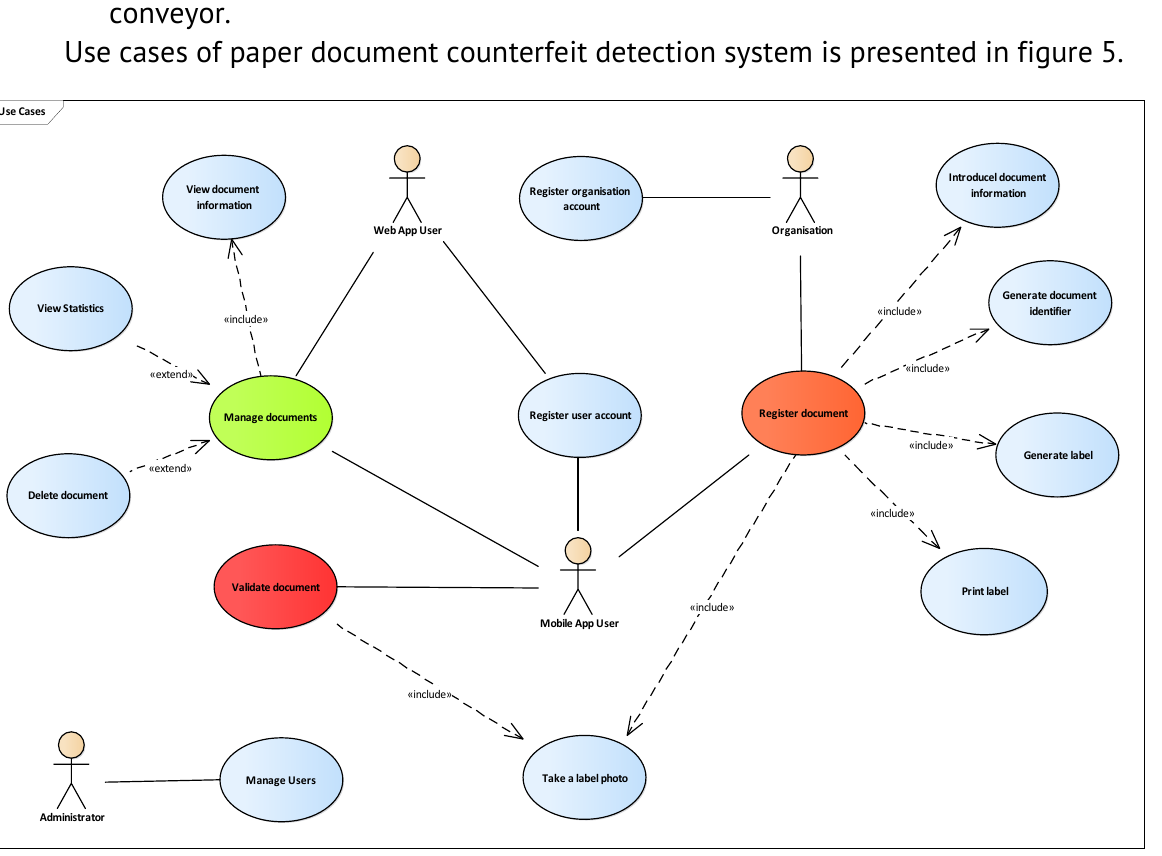
Figure 5. Use cases of paper document counterfeit detection